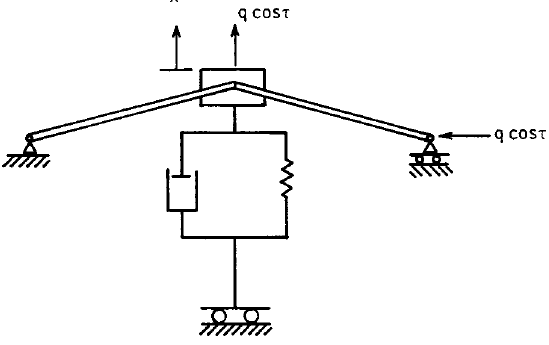
Fig. 1. A parametrically excited